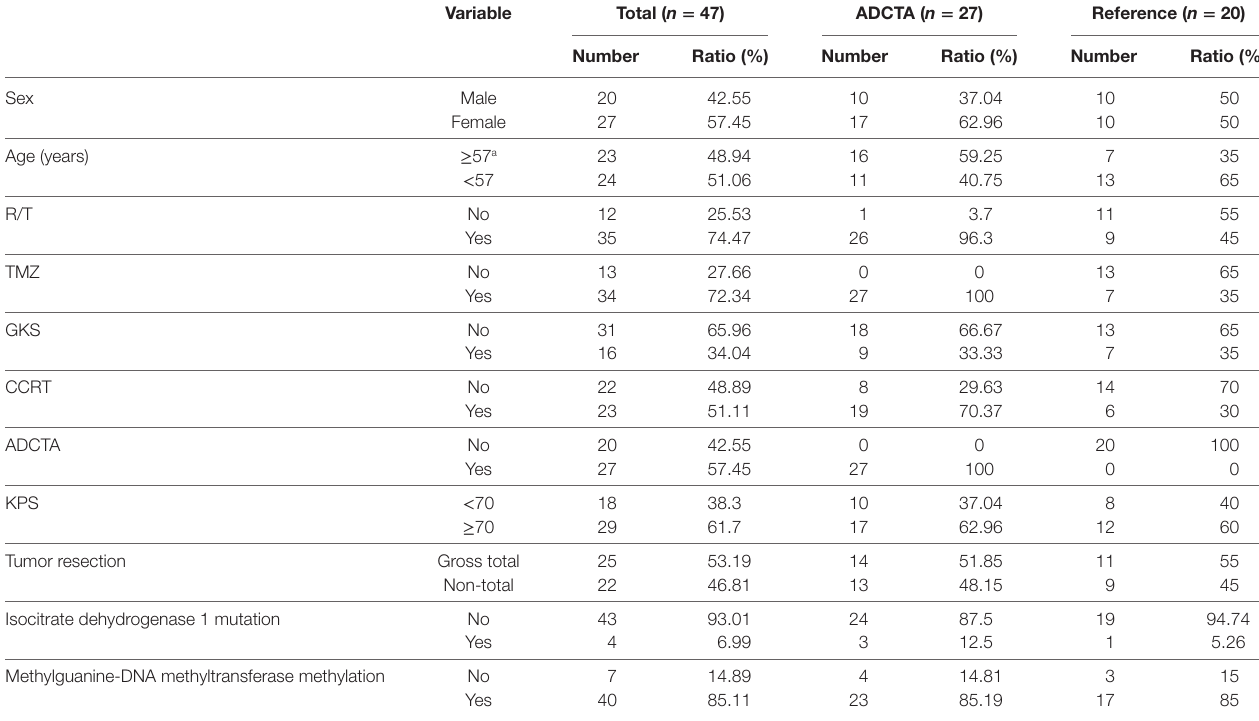
TaBle 1 | Demographic data of total patients and ADCTA and reference